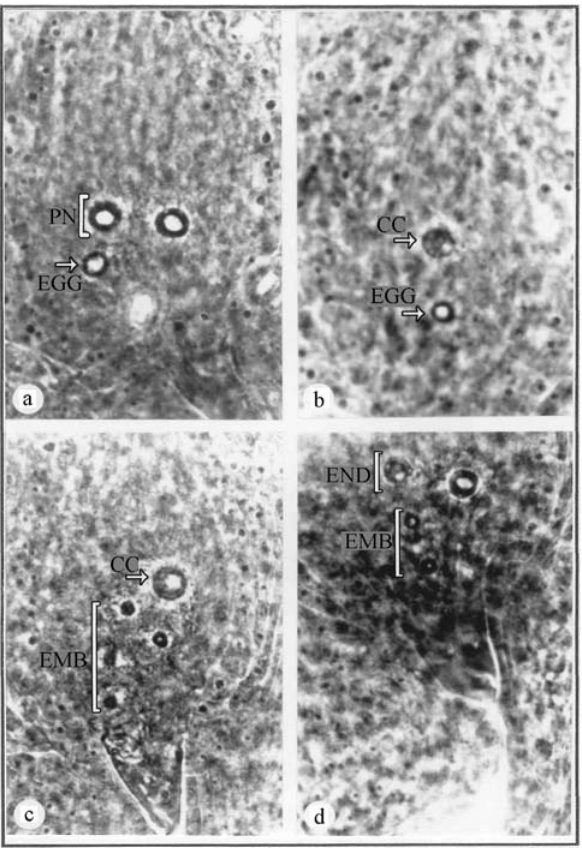
Figure 2 - Embryo sac and embryo formation in Eupatorium laevigatum . Key: a = Embryo sac showing egg and two polar nuclei (PN); b = Embryo sac with egg and central cell (CC); c = Embryo sac with embryo (EMB) and central cell (CC); d = Embryo sac with initial divisions of embryo (EMB) and endosperm (END). All